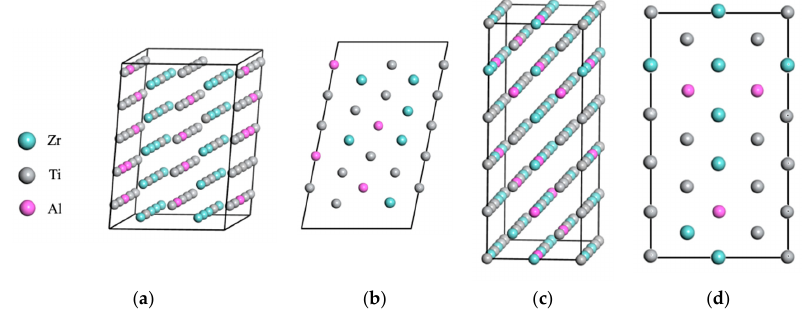
Figure 1. Special quasi-random structure (SQS) model of Zr 35 Ti 50 Al 15 (at.%) alloys: ( a ) hexagonal close-packed (HCP) structure in 3D; ( b ) HCP structure in 2D; ( c ) body-centered cubic (BCC) structure in 3D; ( d ) BCC structure in 2D. Metals 2020 , 10 , x FOR PEER REVIEW